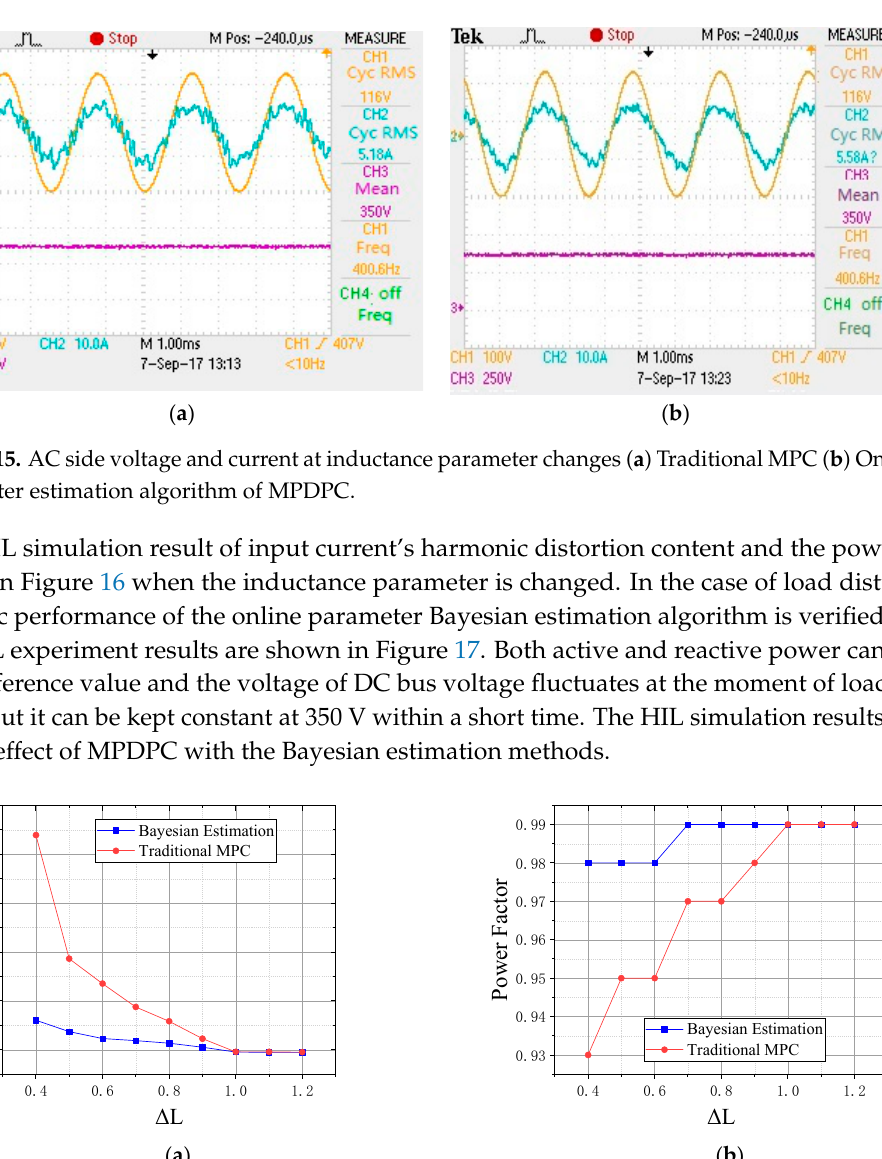
Figure 14. Typhoon semi ‐ physical test platform diagram and practicality. ( a ) The basic theoretical diagram for the HIL system; ( b ) The hardware configuration for the HIL ‐ platform.